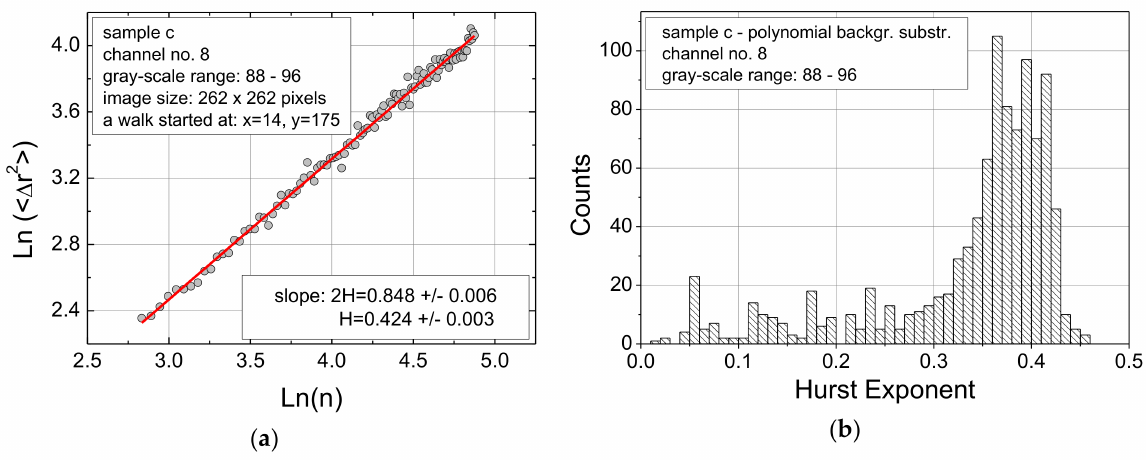
Figure 4. Example of the random walks evaluation on AFM gray-scale-resolved images: ( a ) linear relation between ln ( (cid:104) ∆ r 2 (cid:105) and ln(n); ( b ) Hurst exponent